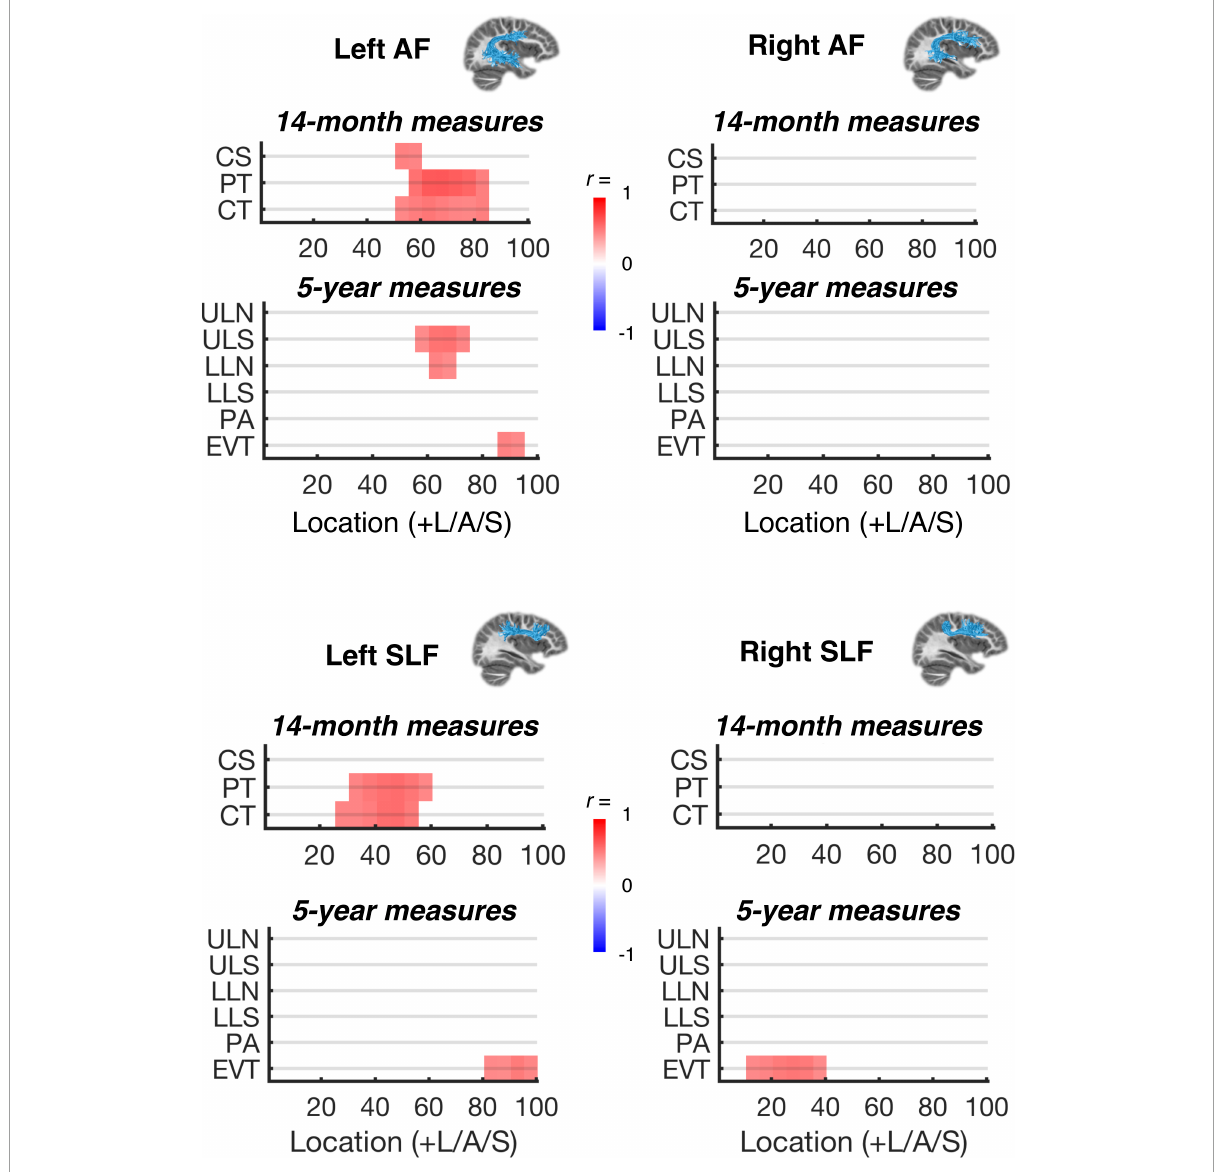
FIGURE2 Correlations between language measures and MPF estimates within dorsal white matter pathways. Significant bivariate correlations ( p < 0.05, corrected for multiple comparisons along each tract; see section “Materials and methods”) are shown for each sampled white matter location within the left and right arcuate and superior longitudinal fasciculus (AF and SLF) and each behavioral variable: 14-month child speech (CS), parentese (PT), and conversational turns (CT); 5-year uppercase letter naming (ULN), uppercase letter sound knowledge (ULS), lowercase letter naming (LLN), lowercase letter sound knowledge (LLS), phonological awareness (PA), and expressive vocabulary test (EVT). Insets (top and middle right) show example tractography-based reconstructions for each of the white matter regions of